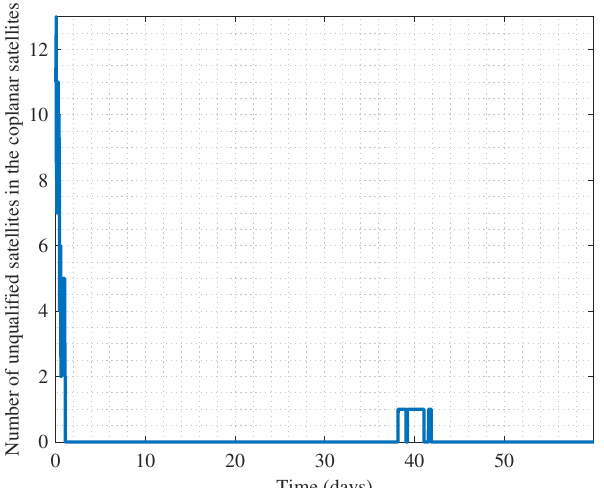
Figure 13. Number of unqualified satellites in the coplanar satellites.